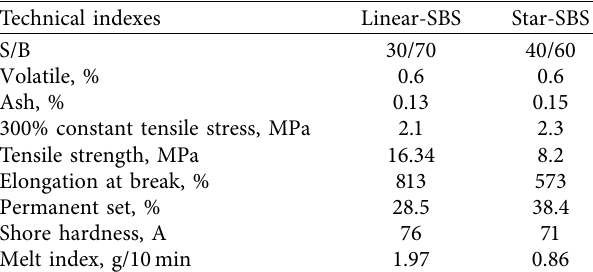
Table 2: Technical indexes of SBS.